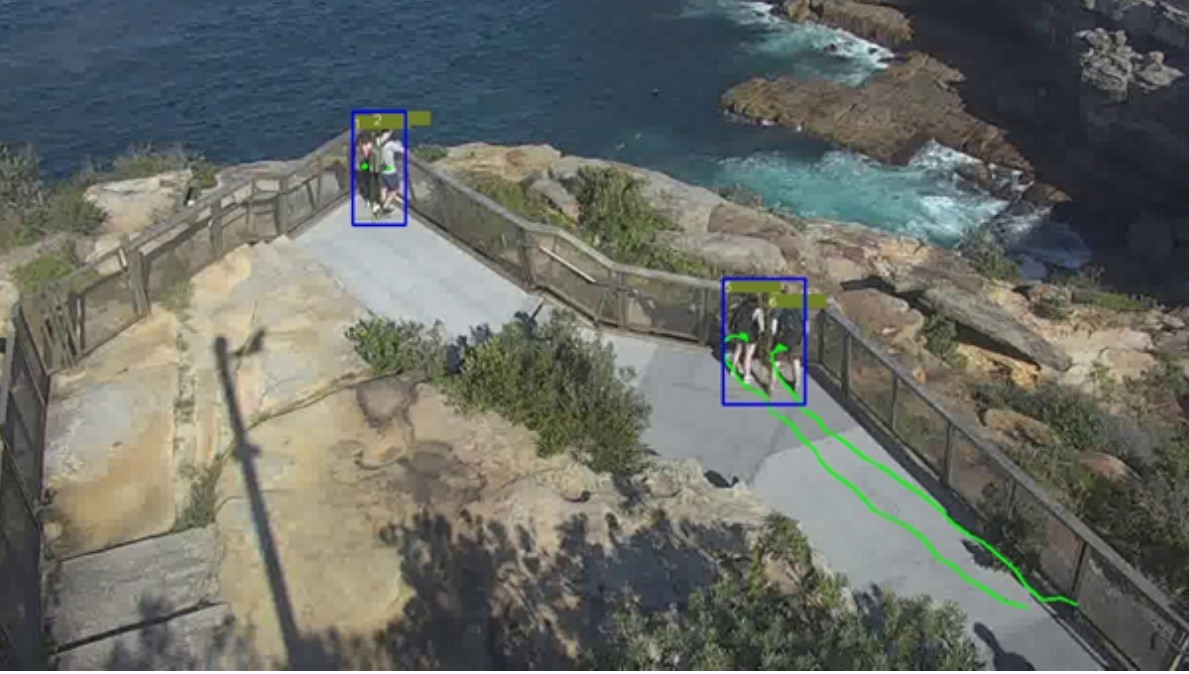
Figure 6. Pedestrian Tracking with Trajectory Functionality. Pedestrians 1 and 2 have been stationary, so the trajectories are collapsed to green dots. Pedestrians 5 and 6 have walked along the fence line, as shown by the green